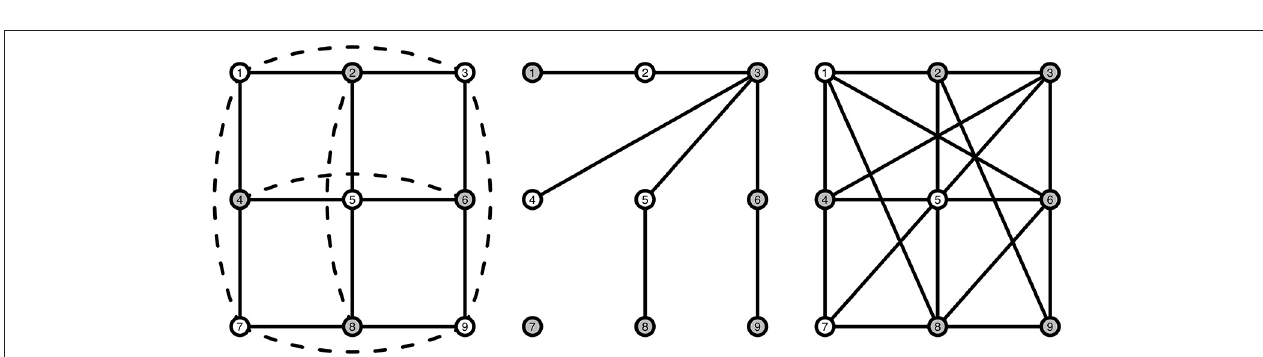
FIGURE 1 | The evolution of the percentage of active nodes for each time point (Left) , and the accompanying bifurcation diagram (Right) . The red line in the bifurcation diagram in the lower figures indicates the estimation of p . The x -axis denotes the probability p for a node to become active. The y -axis denotes the proportion of nodes in the system that are active.